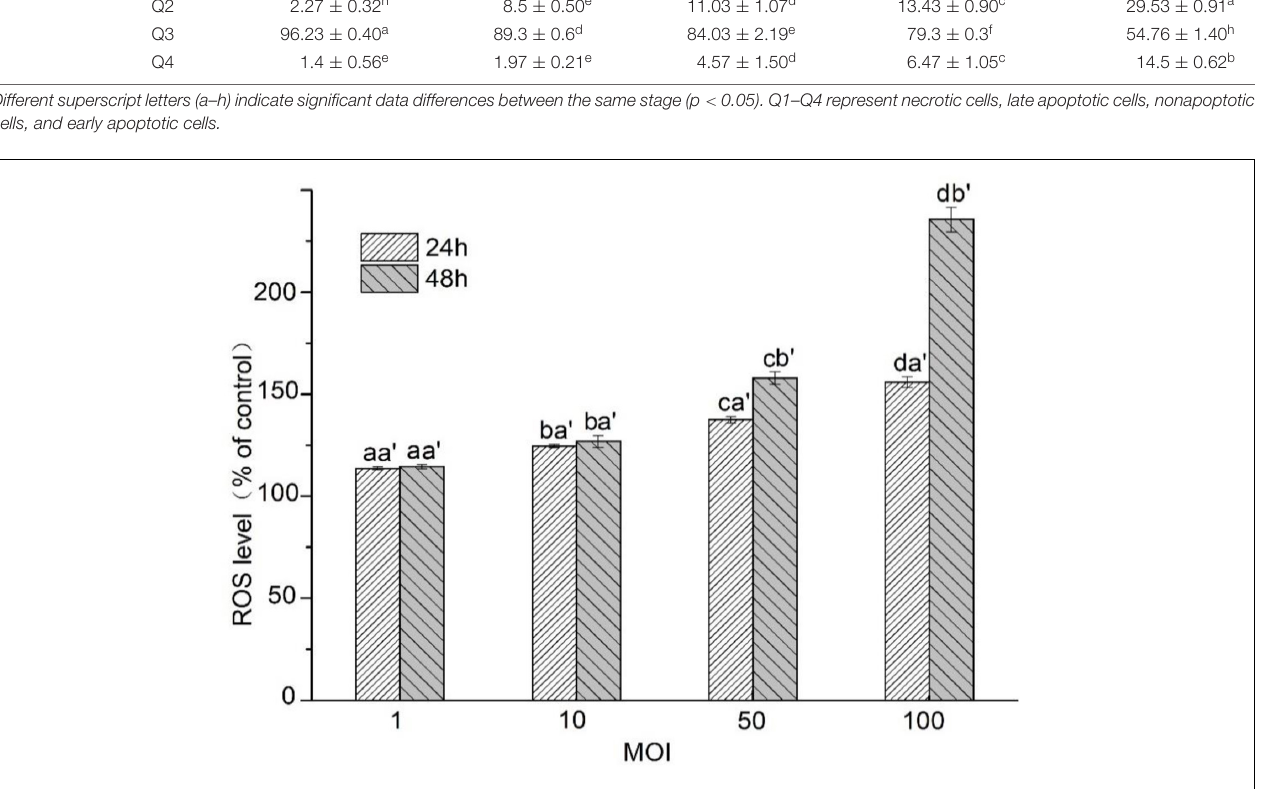
RAD17 , FNIP2 , DOK3 , and CLN8 genes in the sample group were lower than those in the control group; that of the sample group including ELANE , AOC1 , PTEN , IL33 , KLHL31 , MAEL , PTPRK , CPEB1 , ABCF1 , IL10RB , and SFRP4 genes in the control group was less ( Figure 6B